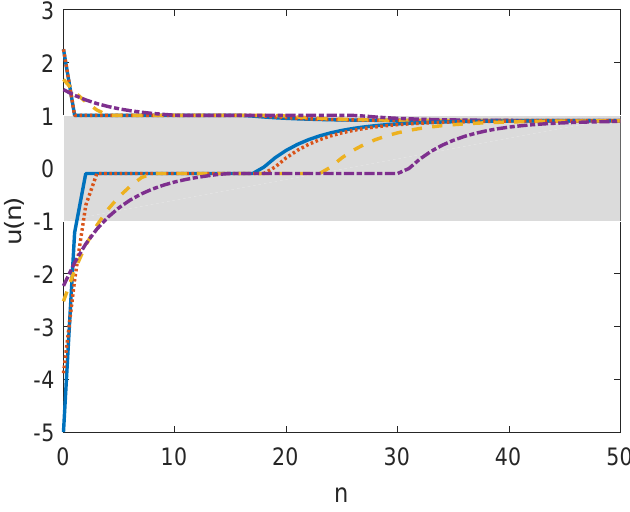
Figure 5. Closed-loop input trajectories of EMPC of Equation (10) with modified zone Z (cid:48) Equation (24), with c 1 = 10 4 and c 2 = 10 2 (solid), c 2 = 10 3 (dotted), c 2 = 10 4 (dashed), c 2 = 10 5 (dash dotted), respectively. Shaded area depicts the input target zone. The upper and lower part correspond to initial state x ( 0 ) = − 5 and x ( 0 ) = 5,